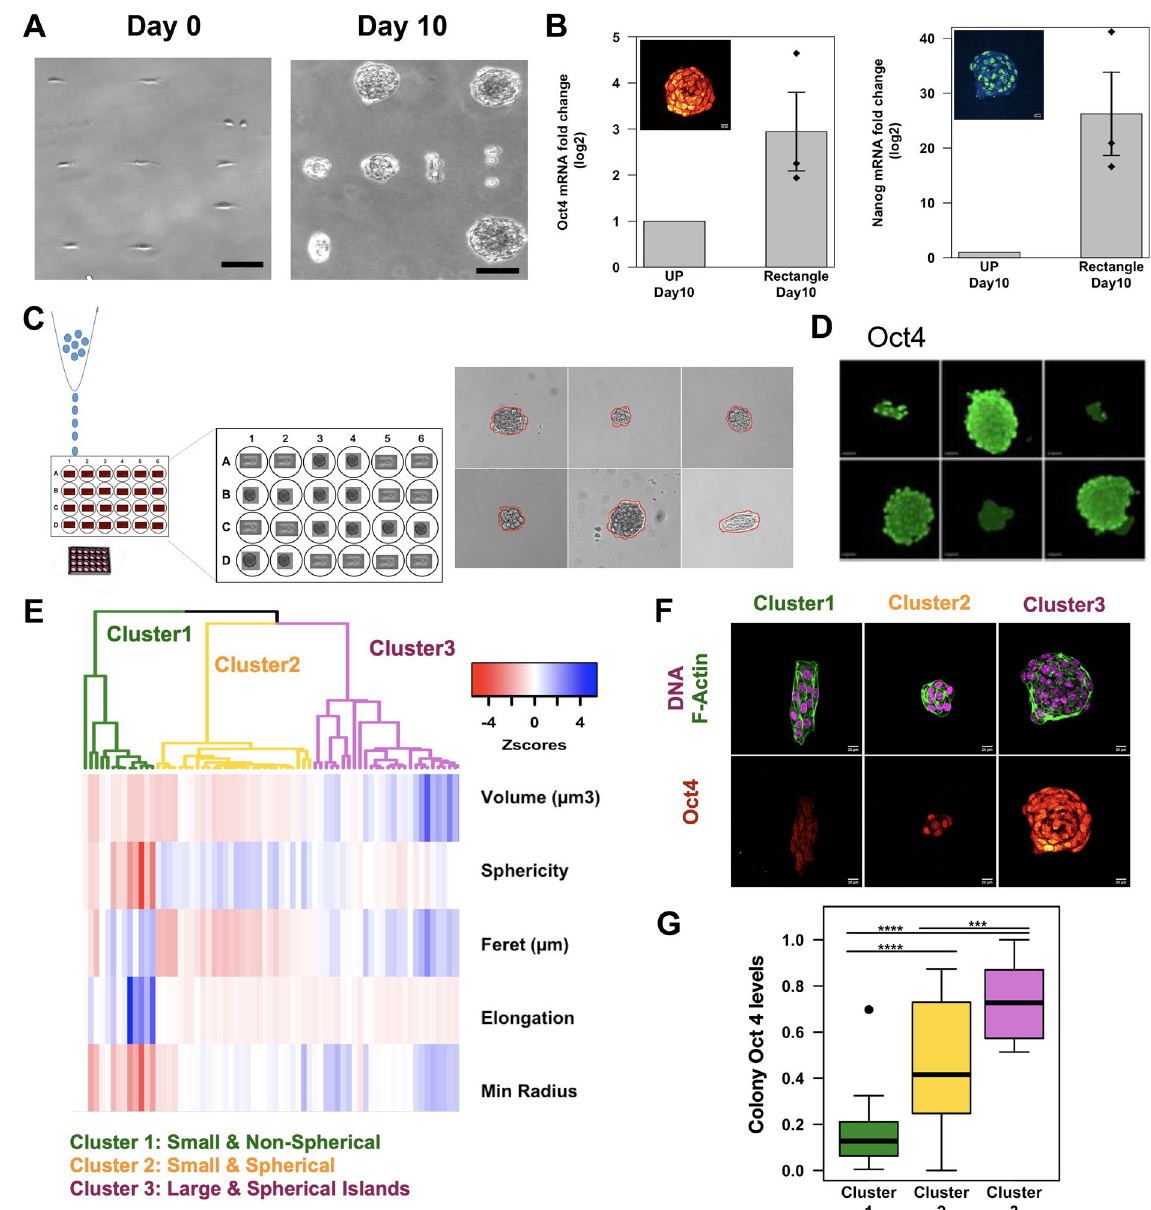
Figure 1. Laterally confined growth of fibroblasts induces cell state transitions: ( A ) representative images of HMF3A cells grown on rectangular patterns at day0, and day 10 of laterally confined growth. Scale bar is 100 microns. ( B ) mRNA levels of Oct4 (left) and Nanog (right) after 10 days of growth on rectangular pattern or unpatterned (UP) cells. Bar plots represent population means and standard error of means. n = 3 biological replicates (p < 0.05, one tailed Wilcoxon rank sum test—hypothesis was that the difference in the mRNA levels between the patterned and unpatterned condition was greater than 0). (Inset) Representative micrograph of a confocal slice of a colony at day 10 stained for Nanog (blue green) and Oct4 (heat colours). Scale bar is 20 μm. ( C ) Schematic describing the experimental setup. Single fibronectin island was stamped per well in a 24 well plate. Using FACs we seeded 1 to 2 cells per well. These were cultured for 10 days under normal culture conditions. (Right) Brightfield images showing colony formation within each well. Red lines are outlines of the colony. ( D ) Images of Oct4 staining within colonies (Green). Scale bar is 20 microns. These are representative results from 2 biological replicates. ( E ) Heatmap of selected morphological features of day 10 colonies, where each column in one colony. Dendrogram shows hierarchical clustering of these colonies resulting in 3 clusters. n = 68 colonies from 3 biological replicates. ( F ) Representative images from each cluster of day 10 colonies stained for DNA (magenta), F-Actin (green) and Oct4 (heat colours). ( G ) Boxplot of average Oct4 levels per colony across the 3 clusters. n = 68 colonies from 3 biological replicates. The Oct4 levels of each colony is treated as an independent measurement and the values are normalized within each biological replicate. Significance codes: ***p < 0.001 and ****p =